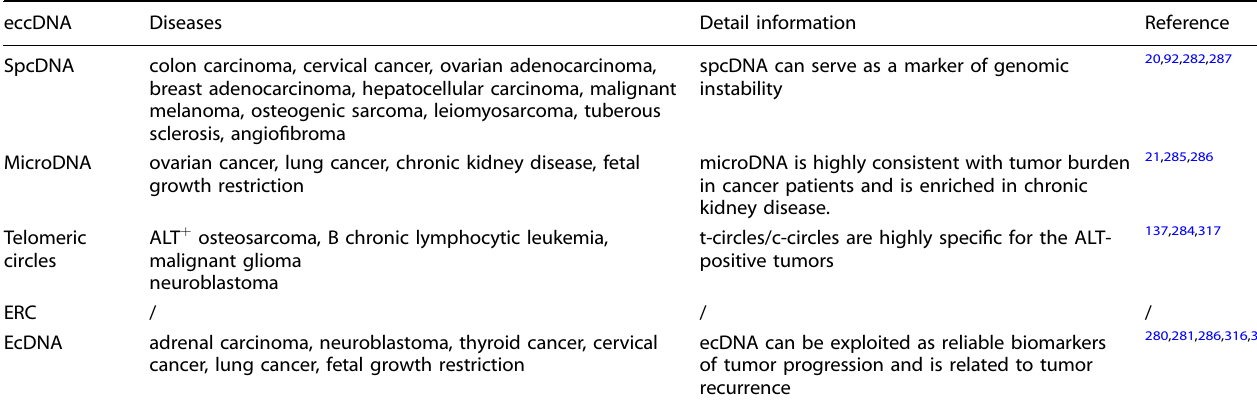
EccDNA extrachromosomal circular DNA, SpcDNA small polydispersed DNA, ERC extrachromosomal rDNA circles, EcDNA extrachromosomal DNA, ALT alternative lengthening of